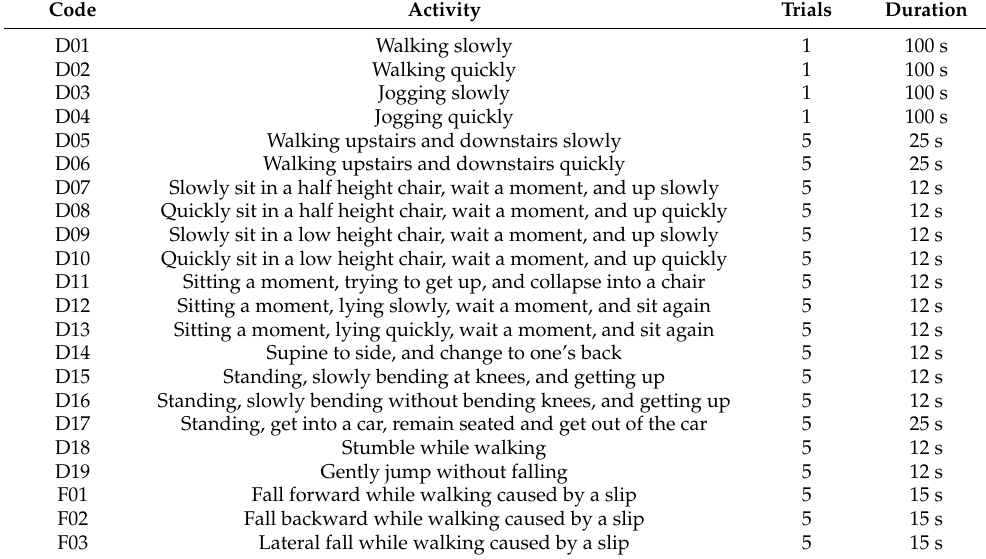
Table 1. Types of activities of daily living and